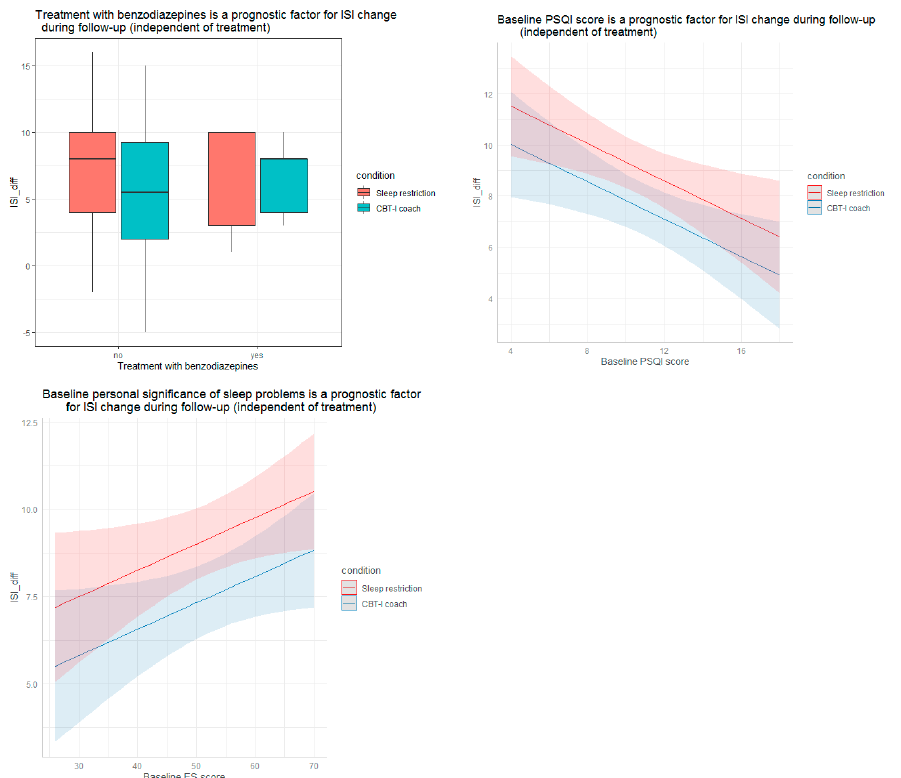
Figure 2. Prognostic value of treatment with benzodiazepines, baseline PSQI score, and baseline personal significance of sleep problems for ISI change after follow up. ISI—insomnia severity index, CBT-I coach—internet-delivered multicomponent cognitive behavioral therapy for insomnia, ISI_diff—the difference of the ISI from pre-to post-treatment (ISI pre-treatment – SI post-treatment), PSQI—Pittsburgh Sleep Quality Index, ES—personal significance of sleep problems.